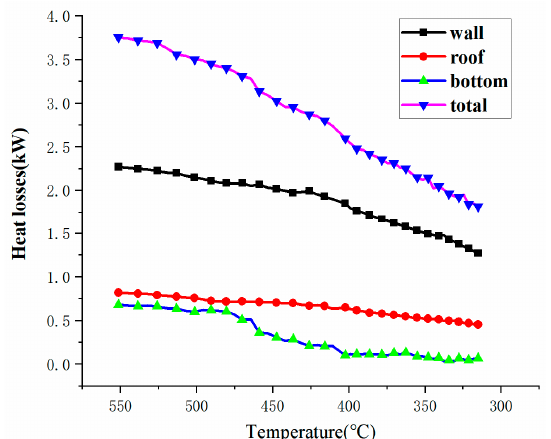
Figure 11. Heat losses from the experimental tank.